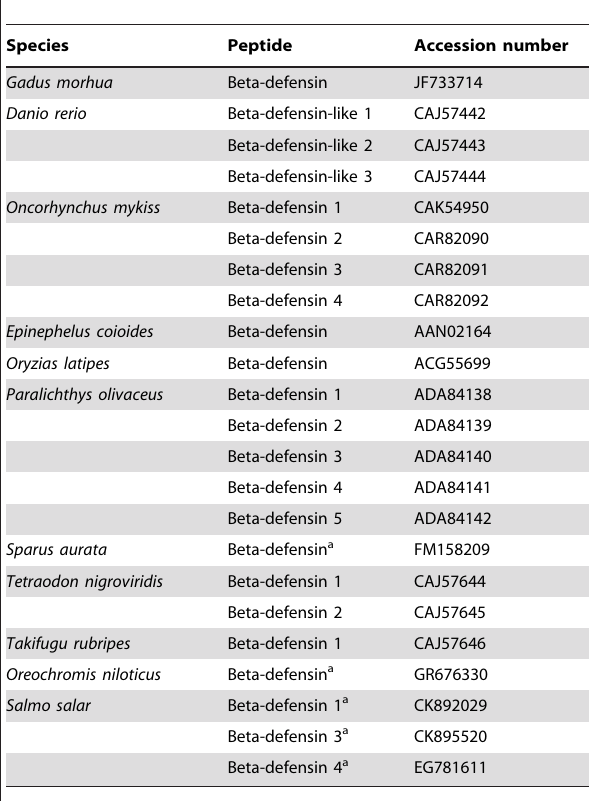
Table 2. Beta-defensins from teleost fish available at the NCBI